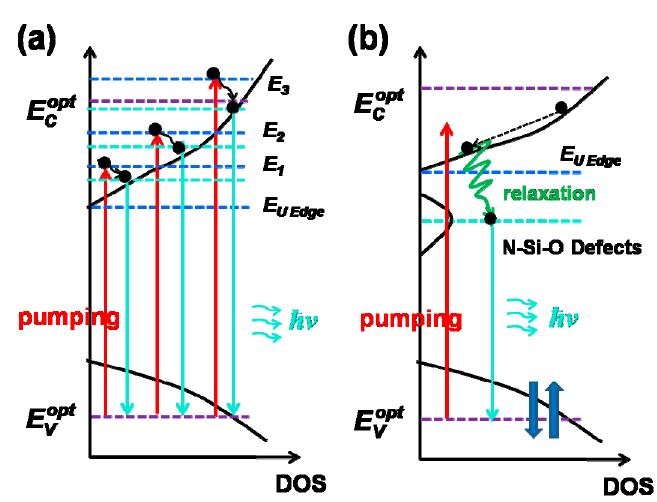
Figure 6. The schematic diagrams of luminescence model and transition of electrons in the band gap: ( a ) a-SiN x ; ( b ) a-SiN x O y .